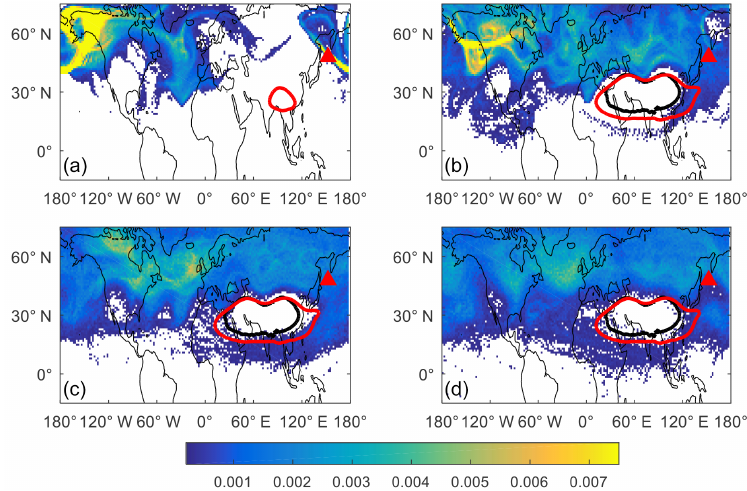
Figure 8. Percentage (%) of air parcels on 12–30 June (a) , 1–10 July (b) , 11–20 July (c) , and 21–31 July 2009 (d) between isentropic surfaces of 360 and 400K from MPTRAC simulations. Results are binned every 2 ◦ in longitude and 1 ◦ in latitude. The monthly mean 14320m geopotential height on the 150hPa pressure surface is marked in red and the monthly mean PV-based barrier on the 370K isentropic surface is marked in black. A PV-based barrier related to the Asian summer monsoon (ASM) was not identified in June 2009. The red triangle denotes the location of the Sarychev volcano.